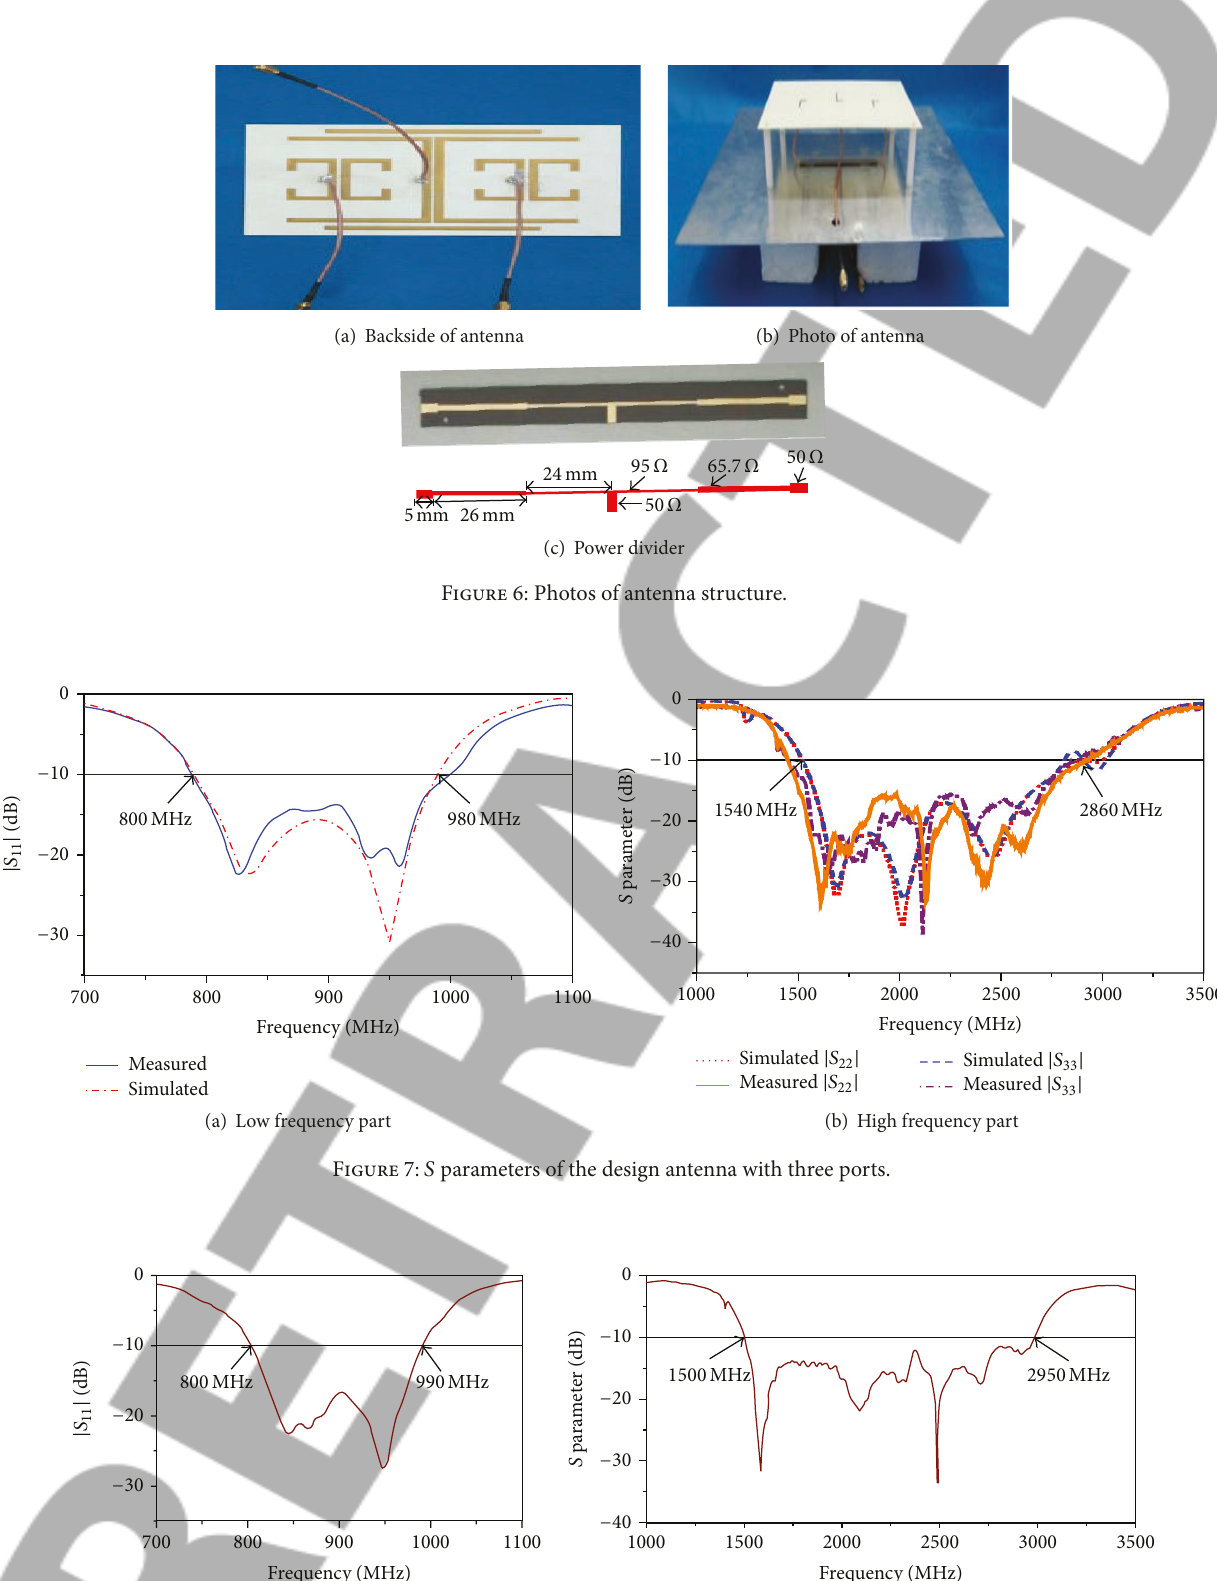
Figure 8: 𝑆 parameters of the antenna with two